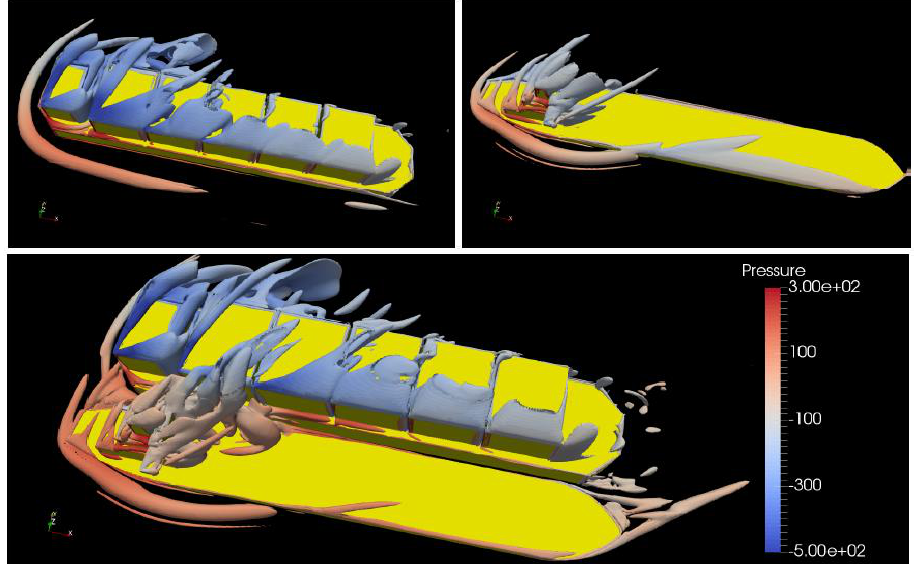
Figure 19. Comparison of Q-criterion between single vessels ( two tops ) and side-by-side configura- tion ( bottom ).